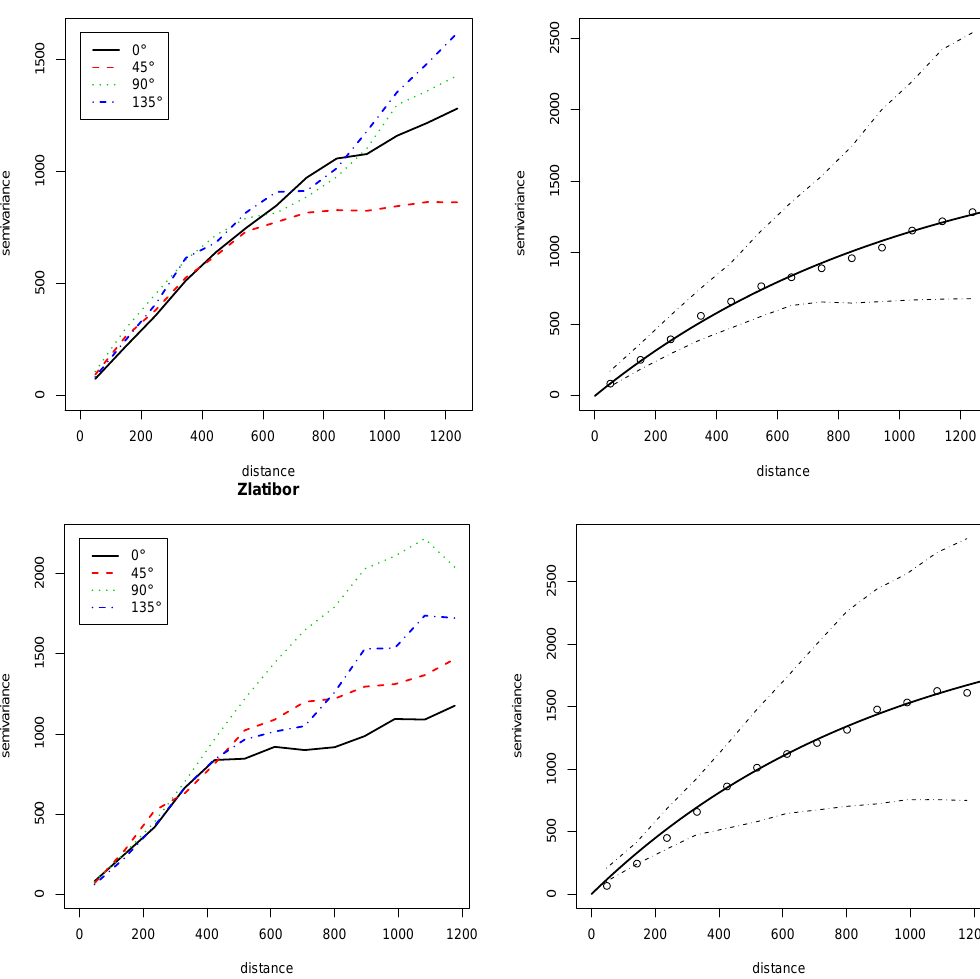
Fig. 4. Variograms fitted for Baranja hill (above) and Zlatibor case studies (below); left: anisotropy in four directions; right: isotropic Mat´ern variogram model fitted using the weighted least squares (WLS) and its confidence